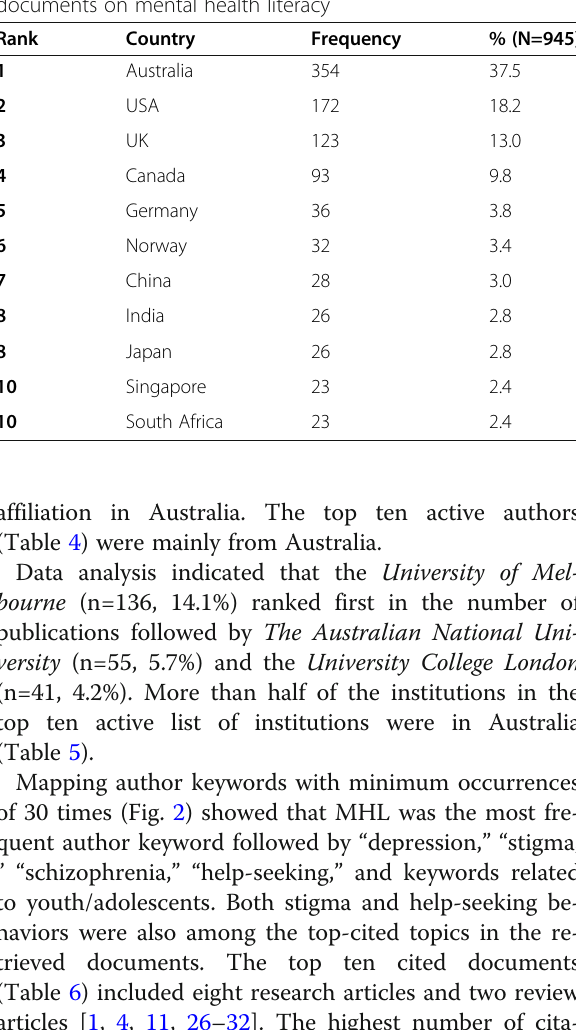
Table 2 Top ten active countries in publishing research